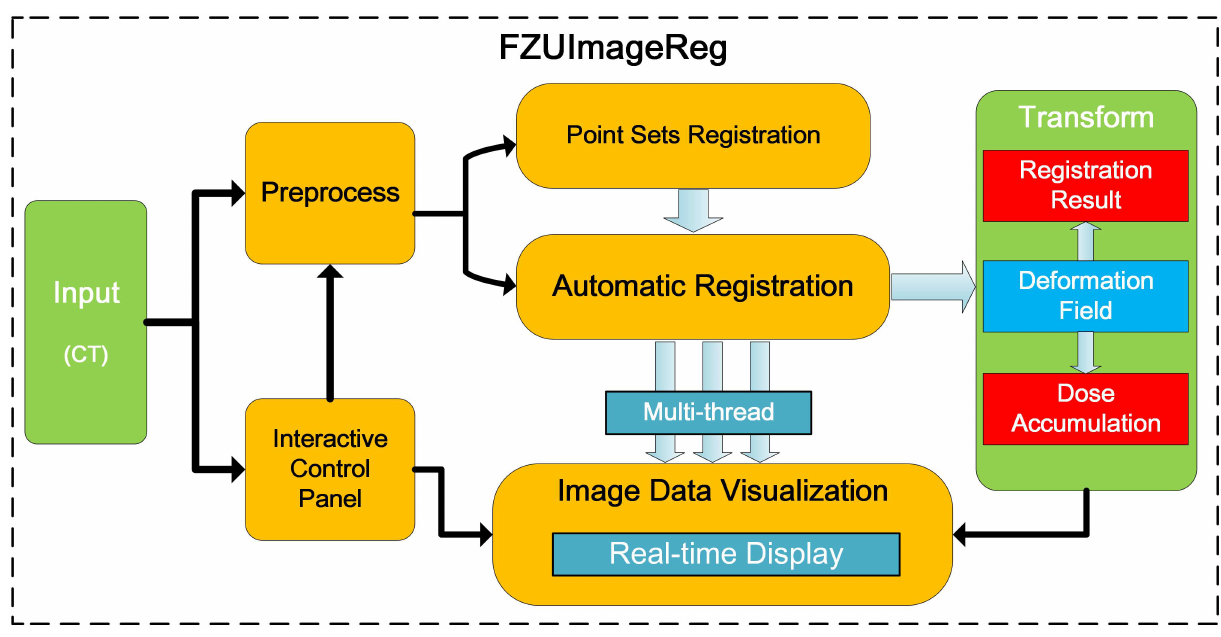
Fig 3. Frameworkand workflow of FZUImageReg